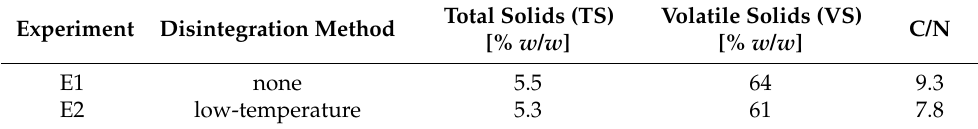
Table 2. Characteristics of the feed used in the